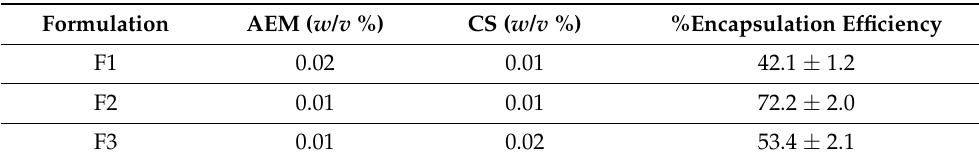
Table 1. % Encapsulation efficiency (%EE) of MTX loaded AEM-CS NPs in mean ± standard deviation (S.D.)/ n = 3.